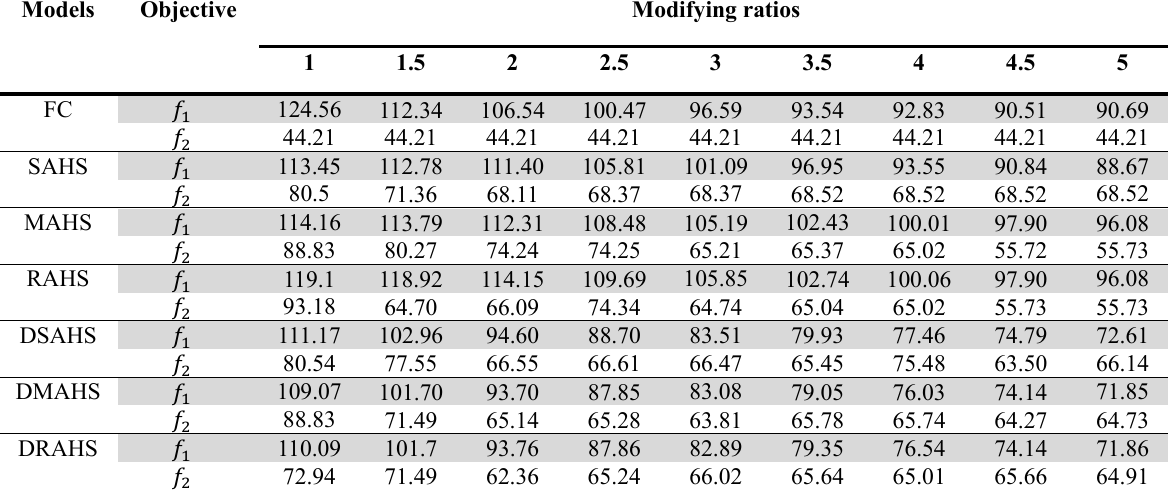
Performance of optimal solutions under different capacity ratios Models Objective